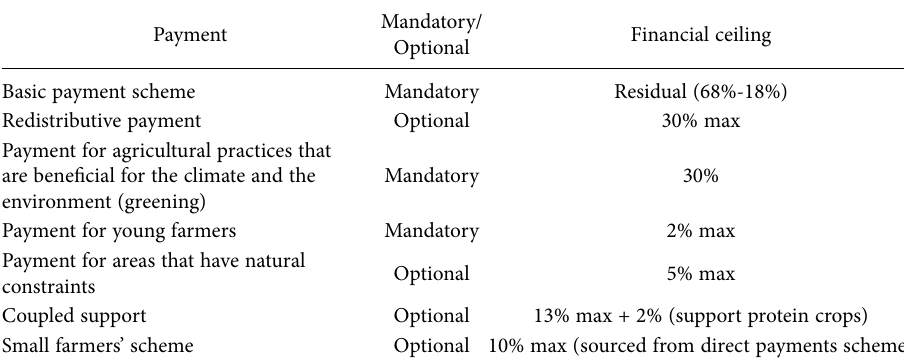
Table 2. The architecture of direct payments